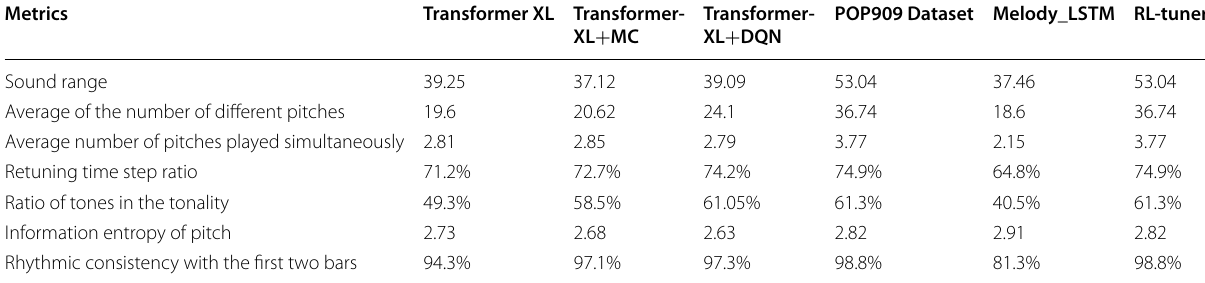
Table 3 Objective evaluation comparison of three methods